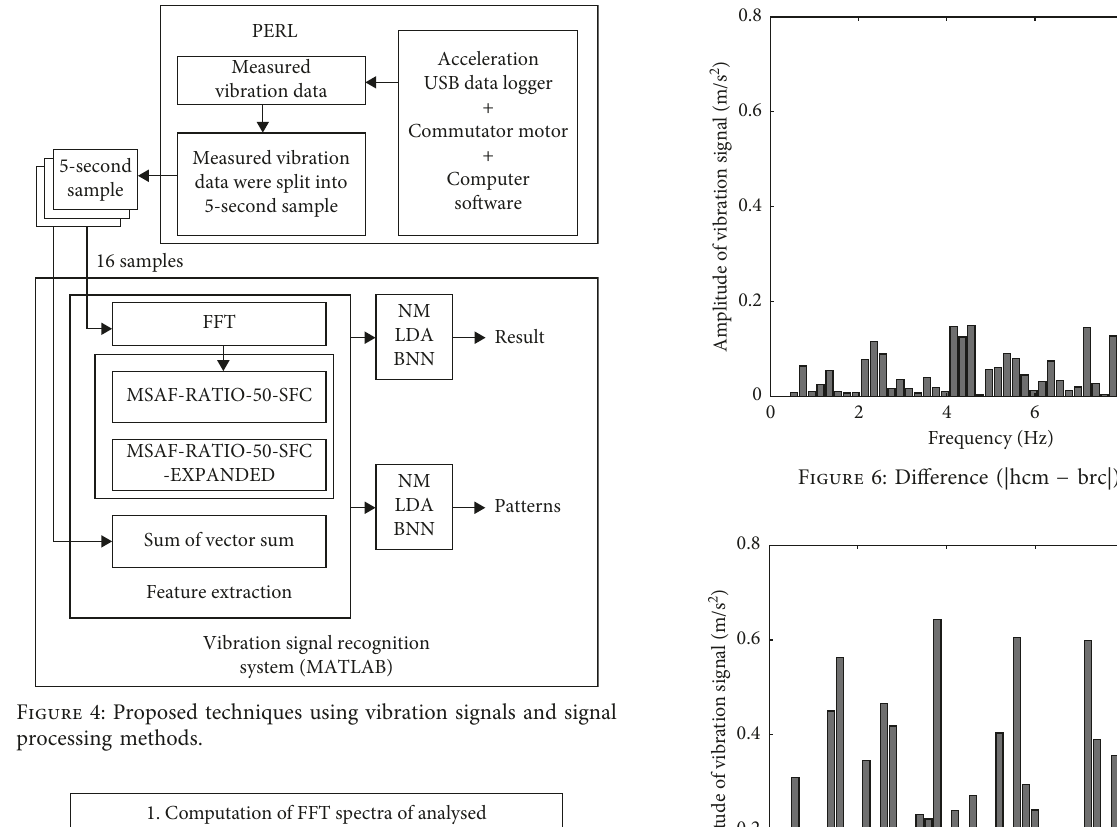
Figure 7: Difference (|hcm